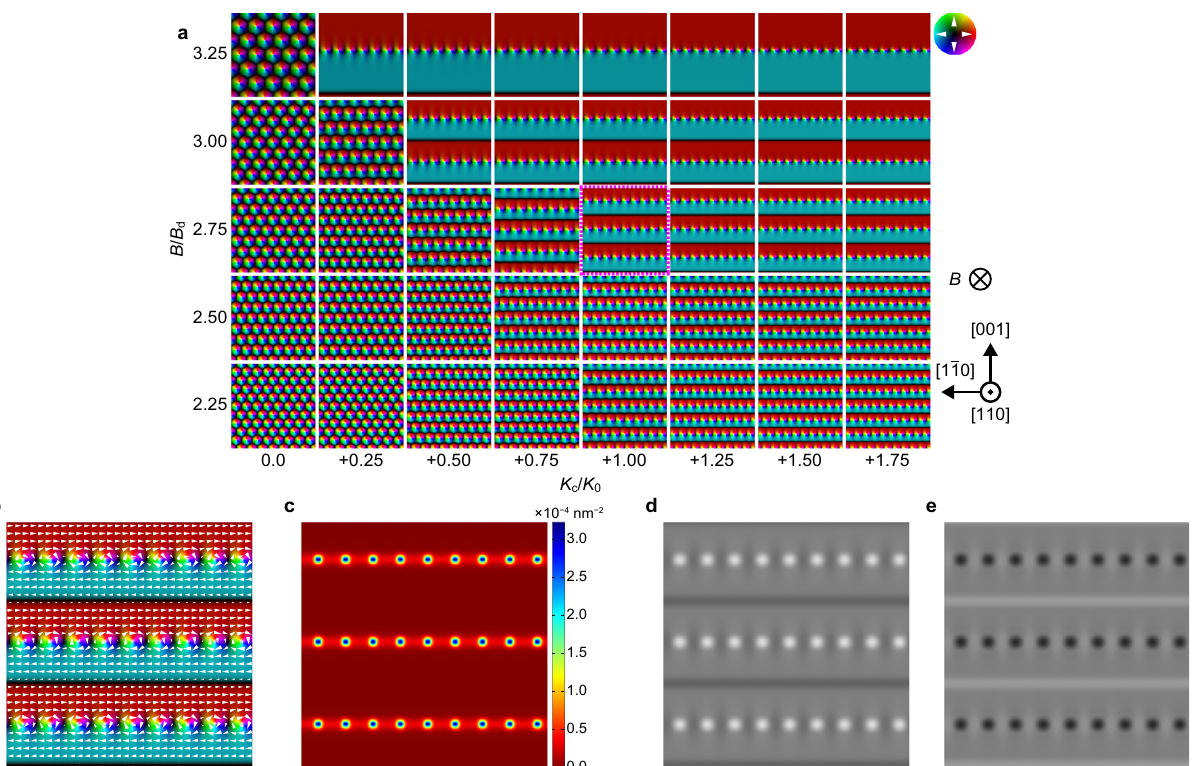
Fig. 4 Micromagnetic and LTEM image simulations of DW bimerons in a cubic chiral magnet (110) thin fi lm with t = 50 nm. a Simulated results of magnetization distributions for various cubic magnetocrystalline anisotropy ( K c ) and magnetic fi elds ( B ). Parameters are as follows: saturation magnetization M sat = 180 kA/m, exchange stiffness constant A = 3.83 pJ/m and DMI constant D = 0.332 mJ/m 2 . K 0 = D 2 /4 A and B d = D 2 /2 M sat A are normalization constants. The magnetic easy axes are the <100> directions ( K c > 0). The size of each image is 1.6 × 1.6 μ m 2 . The color wheel (upper right panel) represents the orientation and magnitude of perpendicularly averaged in-plane components of truncated in-plane conical magnetization to the plane. The white and black indicate + z and − z directions, respectively. b Enlarged view of magnetic structure corresponding to magenta dotted box in a . c Calculated TCD map for b . d , e Simulated underfocused ( Δ f = − 1.5 mm) ( d ) and overfocused ( Δ f = + 1.5 mm) ( e ) LTEM images for b . Further details are shown in Supplementary Fig.